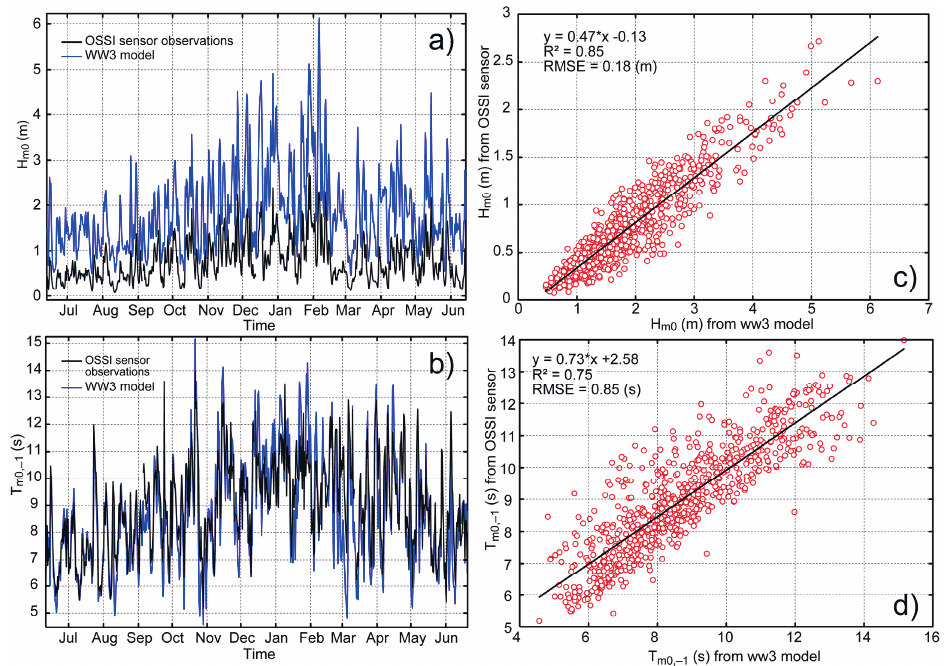
correlation between both the Roscoff and Guissény sites. The mean deviation is 18 cm, with variations between 25 cm for spring tides and 5 cm for neap tides (Figure 6c).